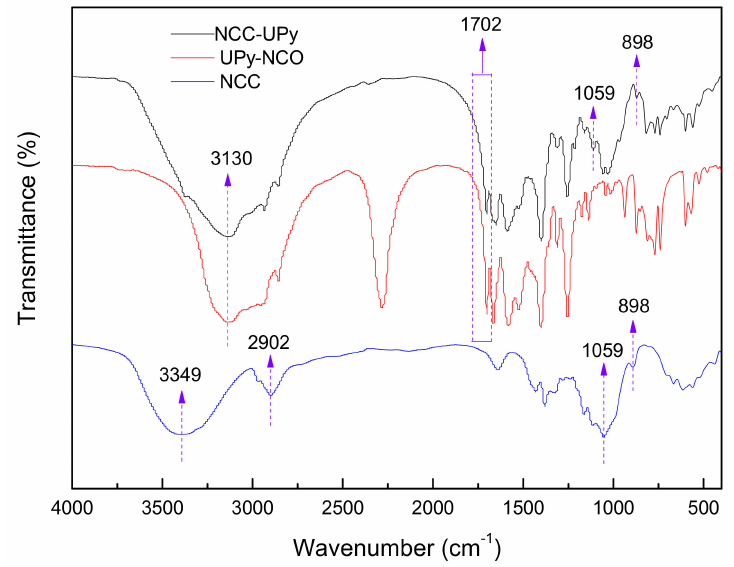
Figure 5. FTIR spectra of NCC and